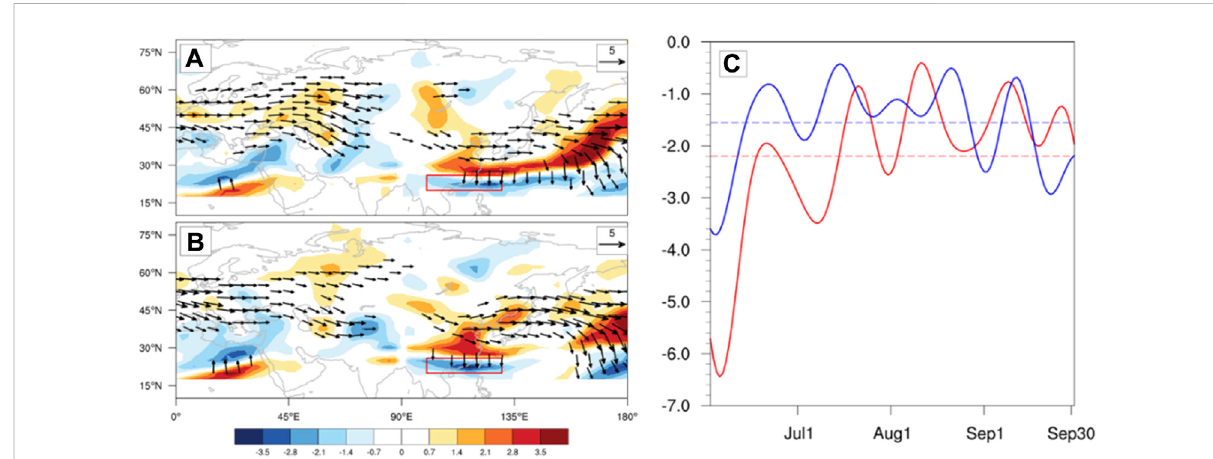
FIGURE 7 Compositesof200 hPawaveactivity fl ux(vectors,unit : m 2 s 2 )anditsdivergence(shaded,unit : 10 − 6 ms 2 ),where (A) forP1positiveyearsand (B) for P2 positive years (Only values signi fi cant at/above the 95% con fi dence level by Student ’ s t test are shown). (C) Time series of multi-year mean wave activity fl ux divergence at 200 hPa averaged over (22 – 26 ° N, 100 – 130 ° E), where the blue line is for P1 positive years and the red line is for P2 positive years (The dashed lines are the averages of solid